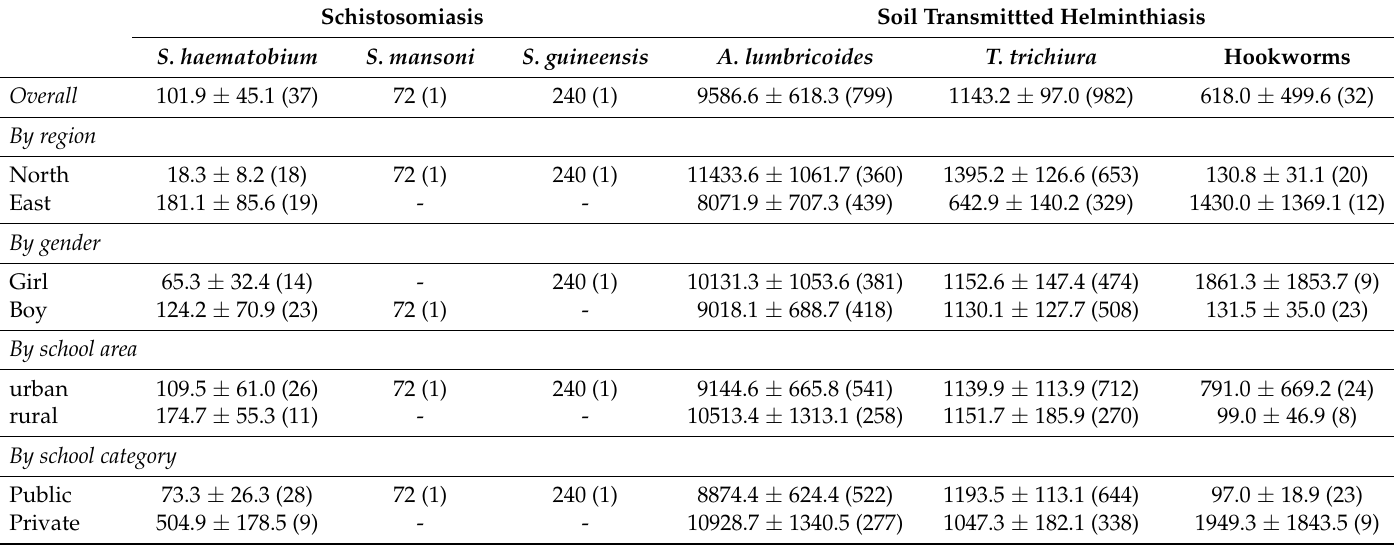
Table 3. Mean intensity of infection ± standard deviation at overall, by region, gender, school area, and school category.